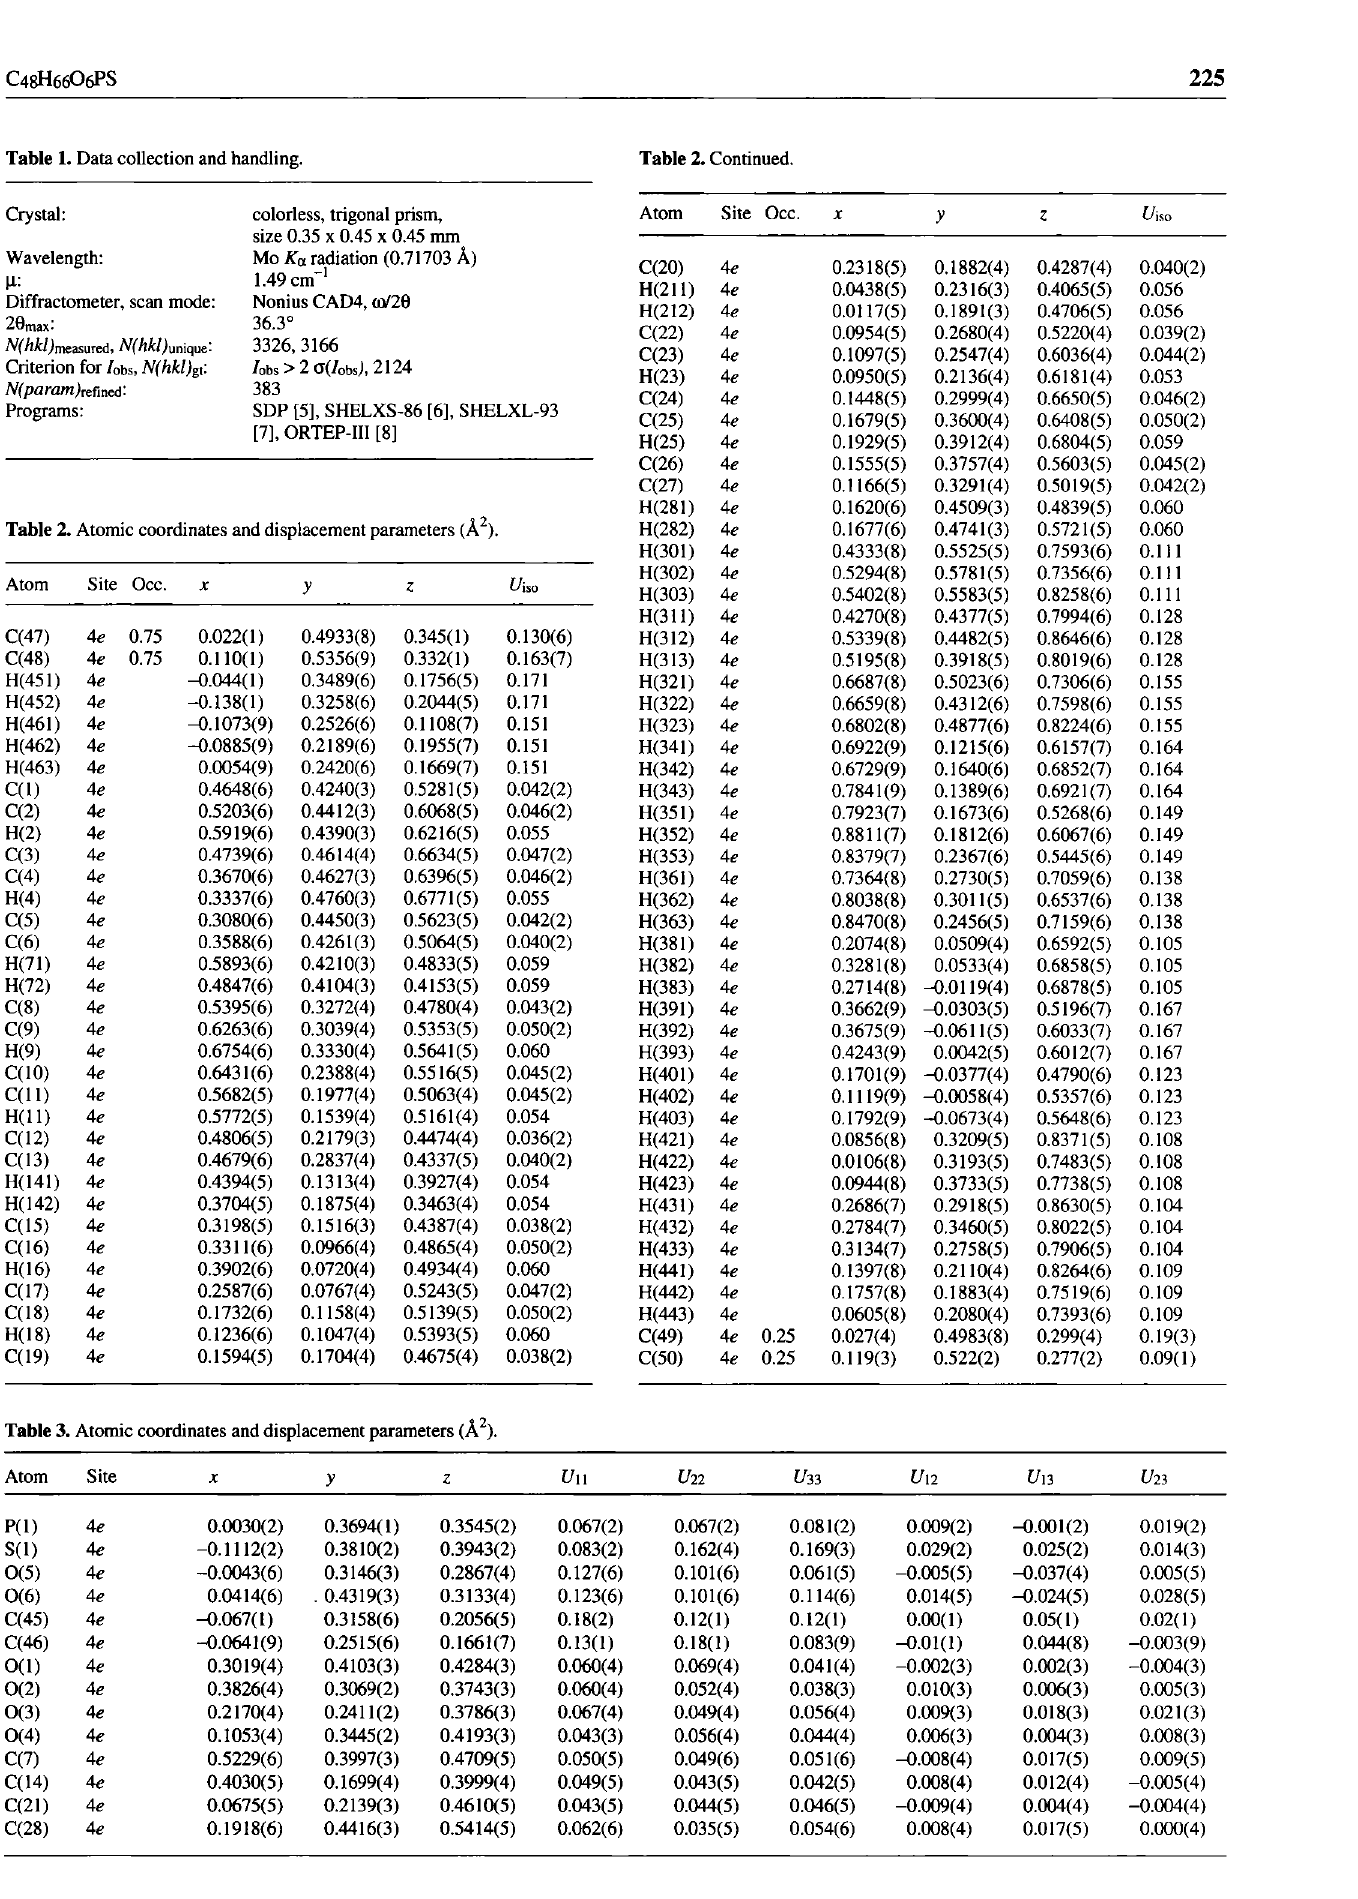
Table 3. Atomic coordinates and displacement parameters (Ä 2